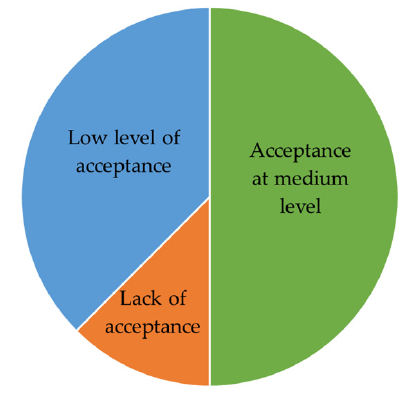
Figure 6. Selected survey results—an analytical–social perspective: how do you assess the level of acceptance by the residents of your province for the creation of RES installations (other than prosumer installations) near their place of residence?